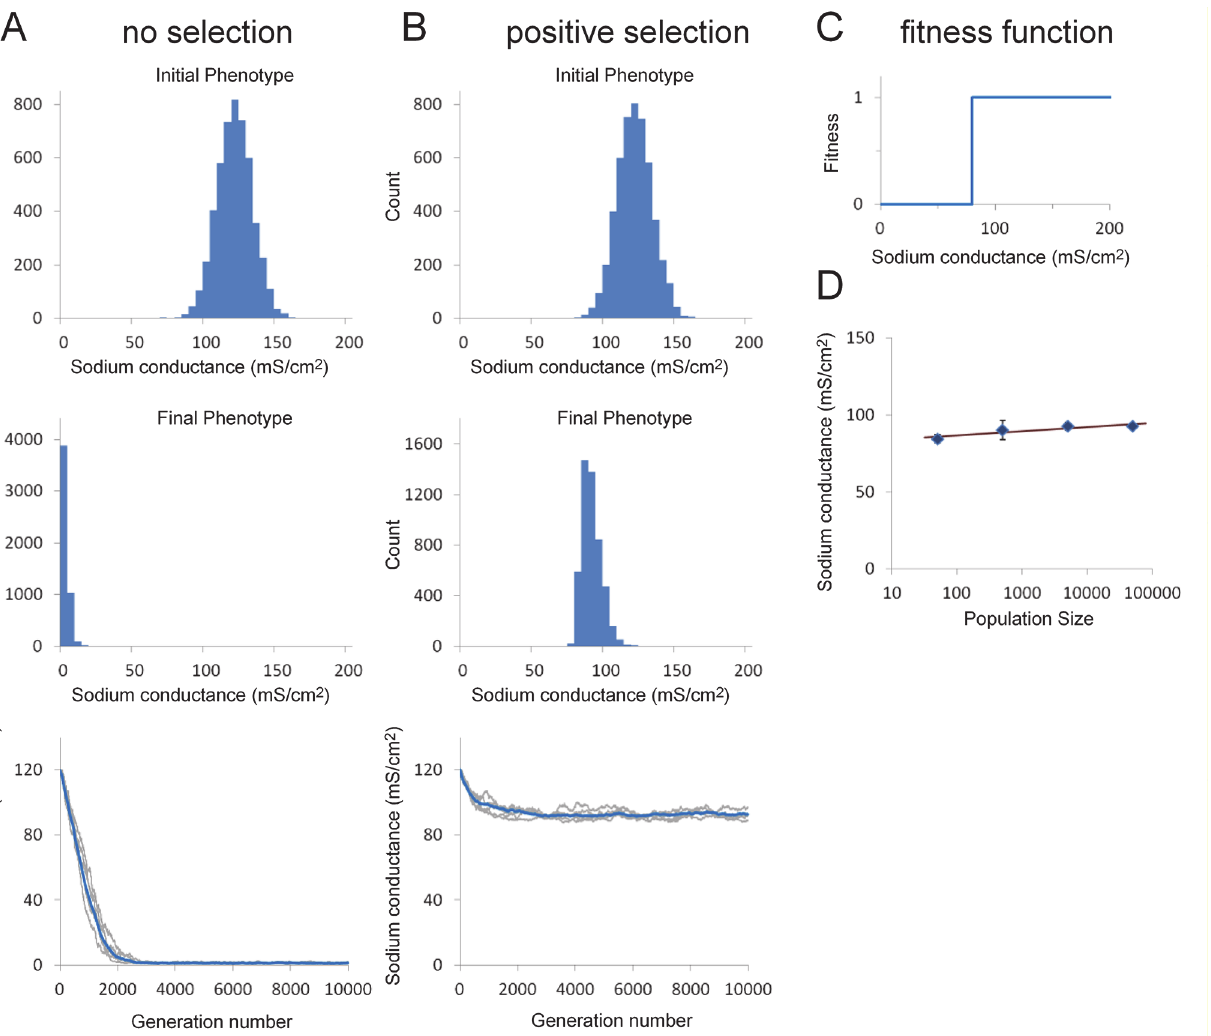
Fig 4. Effect of selection for action potential conduction on sodium channel expression over successive generations. A. Evolution of sodium conductance phenotype in the absence of any selection over 10000 generations (population size = 5000). Histograms show starting (top) and final (middle) phenotype distribution. The bottom panel shows how the average sodium conductance within the population evolves over time (10000 generations). The blue line is the average value of ten simulation runs and five independent runs are shown in light grey on the same graph. The average final conductance value was 1.2 ± 0.1 mS/cm 2 (mean ± S.D., n = 10). It takes approximately 3000 generations to reach steady-state. B. Evolution of sodium conductance phenotype in the presence of positive selection, based on the fitness function shown in (C). Other parameters are the same as in (A). Average final conductance value was 92.7 ± 2.21 mS/cm 2 . C. The fitness function used in (B). This was based on the minimum sodium conductance required to maintain conduction along the axon at a temperature of 26°C. The plateau value of the step fitness functions has no significant effect on the results and a value of 1 was chosen for computational efficiency. D. Dependence of mean conductance on population size for the model shown in (B). Each ten-fold increase in population produced a 2.7 mS/cm 2 increase in average conductance. Data points are means of ten simulation runs and error bars are